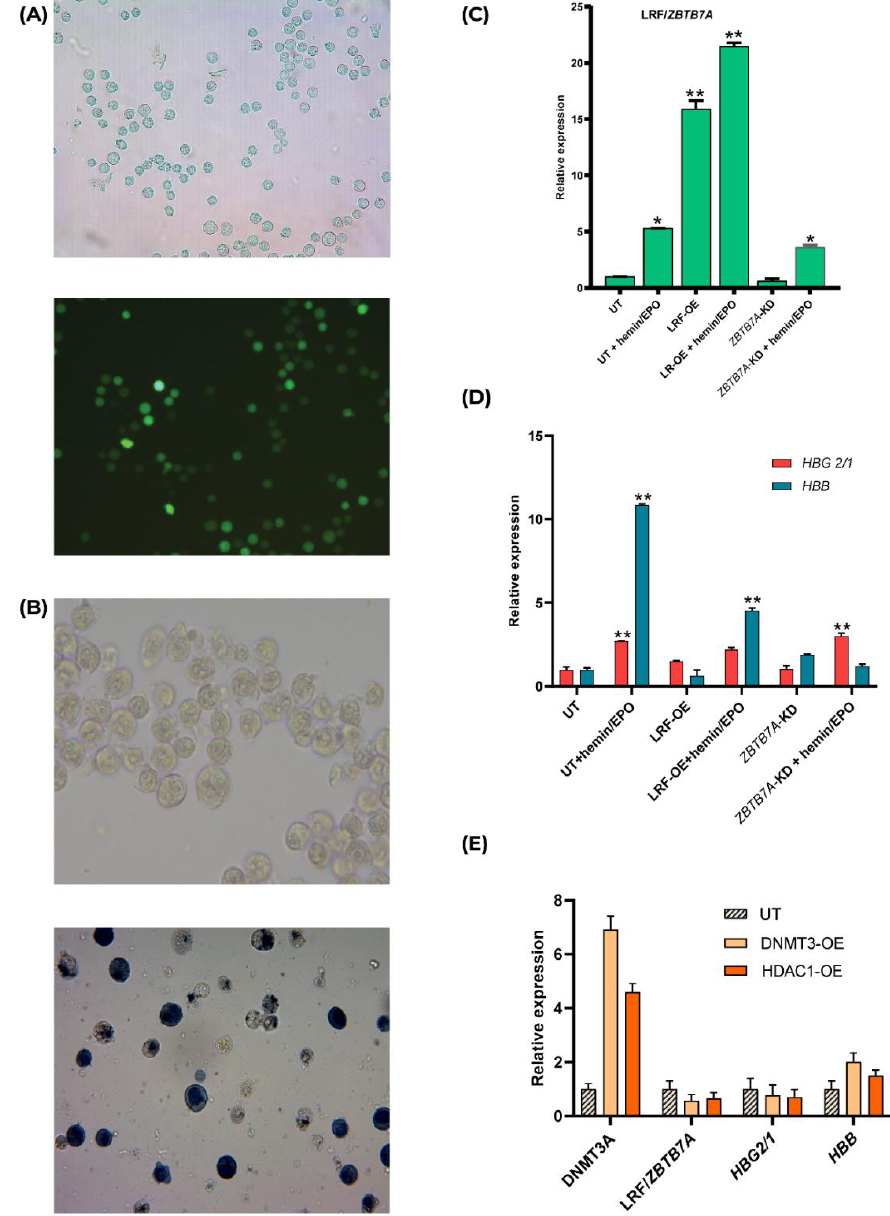
Figure 1. LRF-, DNMT3A-, HDAC1-overexpressing (OE) K562 clones and induction of erythropoiesis. ( A ) eGFP detection in LRF-overexpressing (OE) K562 cells, 2 months post transfection. Images derived from phase contrast (up) and fluorescence (down) microscopy. ( B ) Benzidine staining of untreated (up) and treated with 30 µ M hemin/5 ng/mL EPOK562 cells. Hemoglobinized cells were stained dark blue. ( C ) Relative expression of LRF/ ZBTB7A in LRF-overexpressing (OE) and ZBTB7A -knockdown (KD) K562 clones, pre-and post-hemin/EPO induction. ( D ) Relative expression of HBG2/1 and HBB in LRF-OE and ZBTB7A -KD K562 clones, pre- and post-hemin/EPO induction. ( E ) Relative expression of DNMT3A , HDAC1 , LRF/ ZBTB7A , HBG2/1 and HBB in DNMT3A-OE and HDAC1-OE K562 clones respectively. Values are normalized to untransfected (UT), non-induced cells. * p < 0.05, ** p <